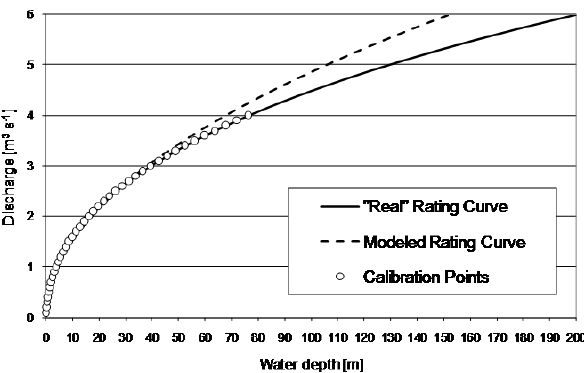
Figure 2. An example of extrapolation using a monomial formula instead Fig. 2. An example of extrapolation using a monomial formula in- of the proper one of Eq. (10) in the case of a trapezoidal cross section. The stead of the proper one of Eq. (10) in the case of a trapezoidal cross dashed line is (cid:133)tted to the (cid:147)observations(cid:148), the circles, supposed to be available section. The dashed line is fitted to the “observations”, the circles, for water depths smaller than 4 m and then extrapolate beyond. supposed to be available for water depths smaller than 4m and then extrapolate On the contrary, DyRaC errors will mostly depend on the estimation of the head loss slope J (which most of the times can be approximated by the water surface slope) as well as on parameter n , the roughness coe¢ cient, and on its variability with the water depth. Fortunately, this dependence can be derived